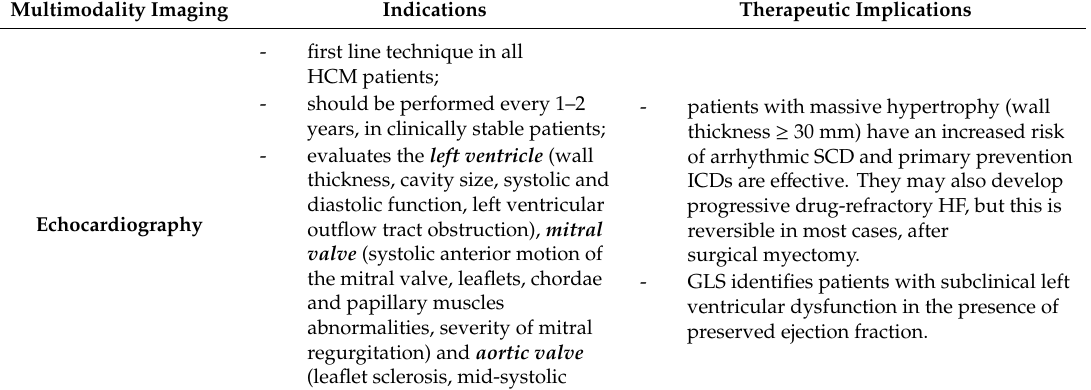
Table 1. Indications and therapeutic implications of multimodality imaging in choosing the optimal treatment in hypertrophic